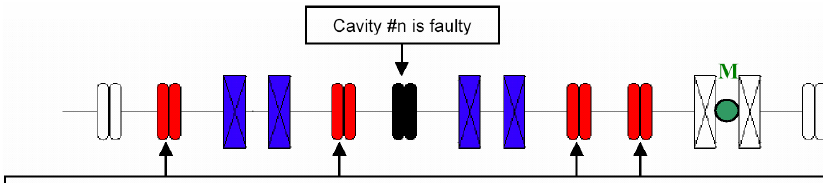
FIG. 2. (Color) Principle of the local compensation